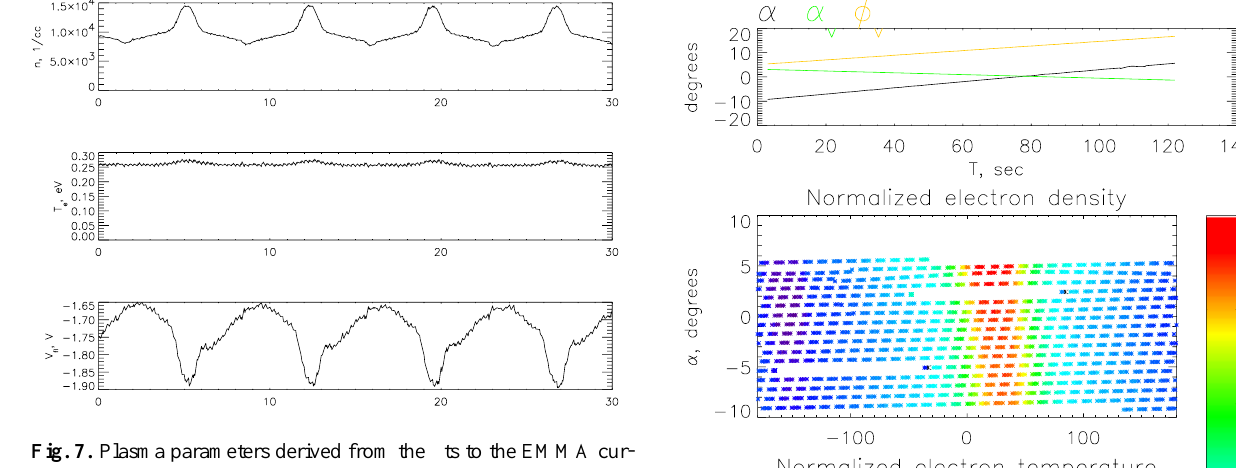
Fig. 7. Plasma parameters derived from the fits to the EMMA cur- rent sweeps for case 1. Panels from top to bottom: electron density, electron temperature and floating potential. Time interval of 30 sec- onds spans four spin periods.